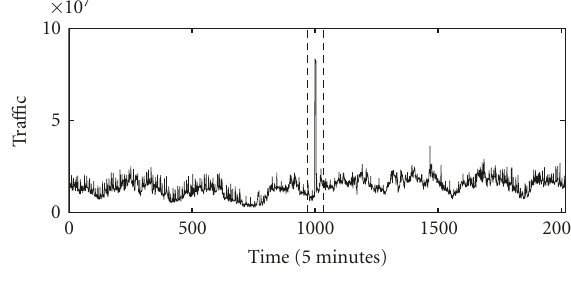
(b) Adding one anomaly in no.50 OD flow (between vertical dash lines) Figure 4: Two anomalies in two